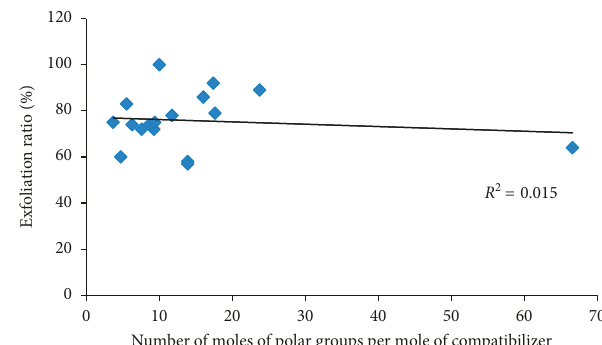
Figure 5: Nanoclay exfoliation ratio as a function of the number of moles of polar groups per mole of